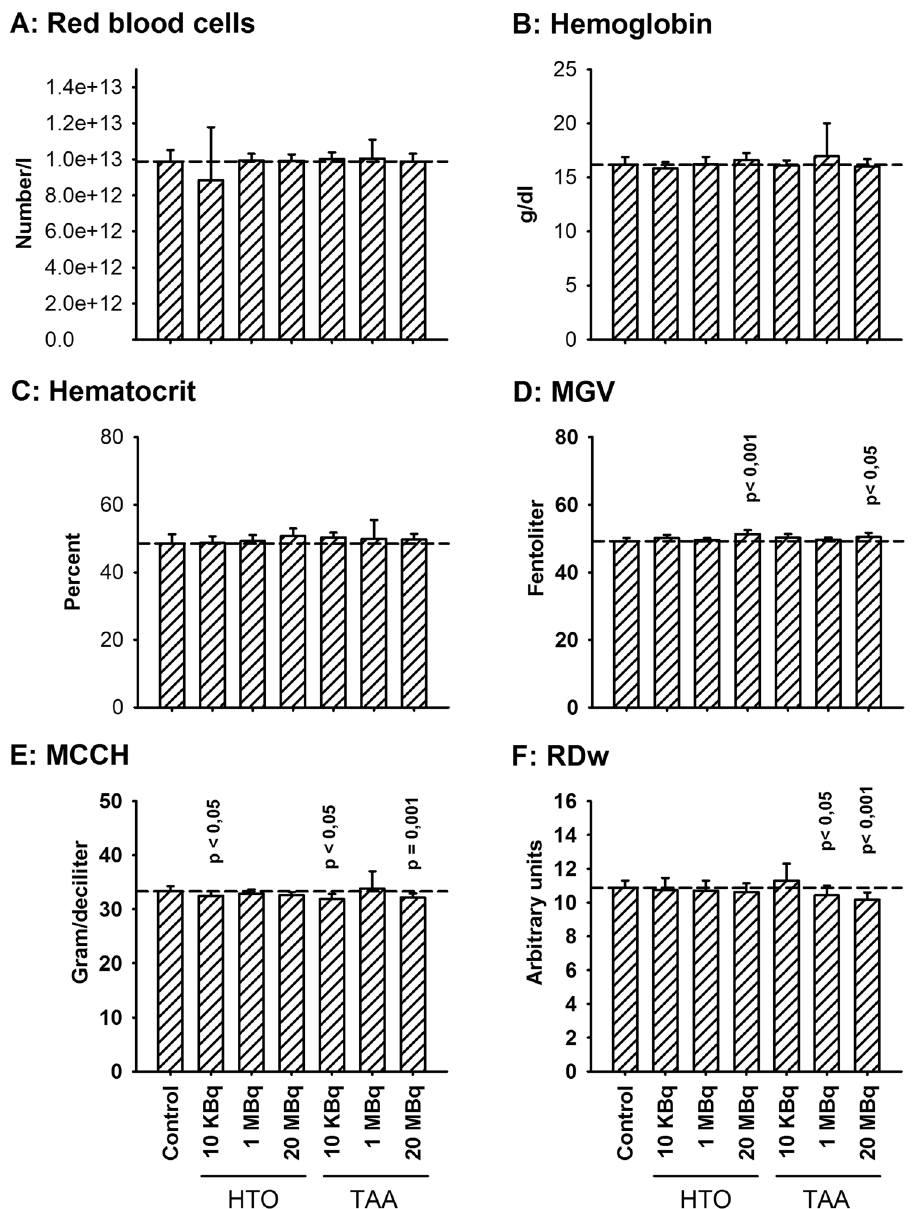
Figure 3. Red blood cell parameters in animals after eight months of exposure to HTO or TAA. ( A ) Red blood cell counts; ( B ) hemoglobin; ( C ) hematocrit; ( D ) mean globular volume (MGV); ( E ) mean corpuscular content in hemoglobin (MCCH); ( F ) RBC distribution index (RDw). Results are mean ± SD, n = 11. Using one-way ANOVA test significant differences were observed for MGV (H (6) = 15.2, p = 0.005), MCCH (H (6) = 15.2, p = 0.018) and RDw (H (6) = 15.4, p = 0.018) but not anymore for RBC counts, hematocrit and hemoglobin. Significant differences with the control group appeared mainly in TAA exposed animals. The horizontal dashed line indicates the mean value for the control